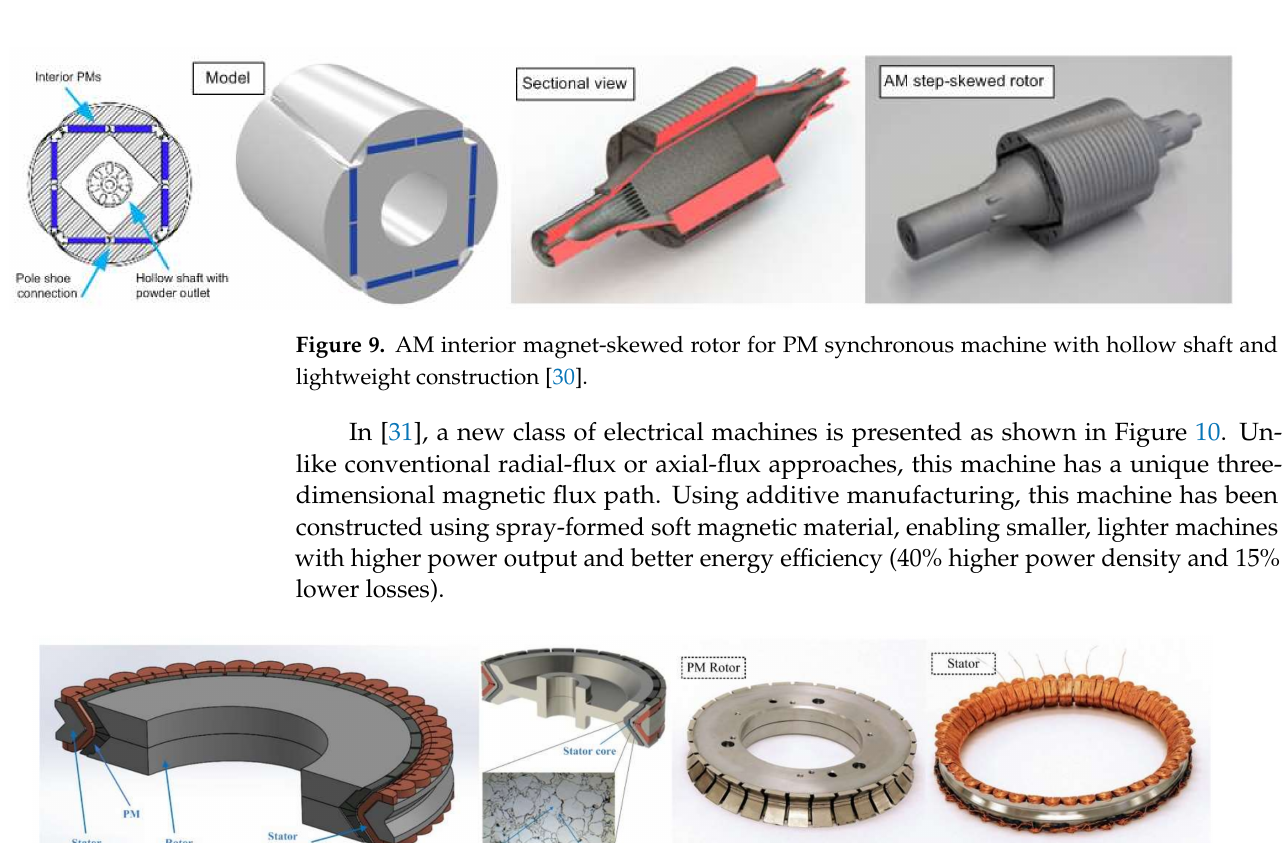
Figure 8. 3D-printed skewed rotor with honeycomb structure cores for reduced torque ripples [29].